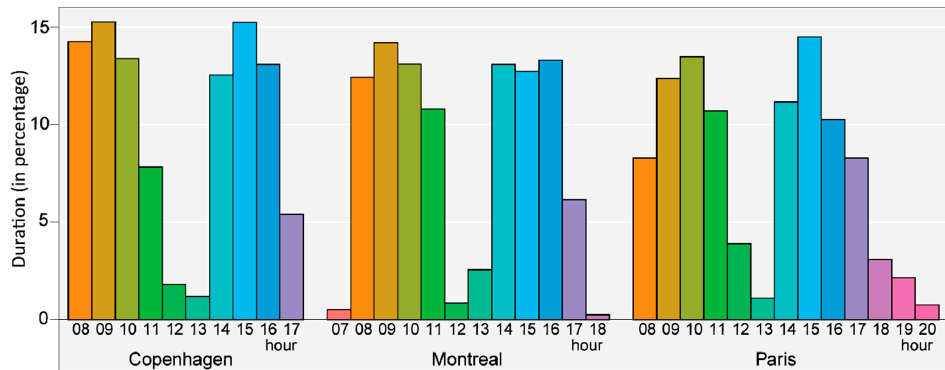
Figure 2. Time spent on each type of road or bicycle infrastructure.